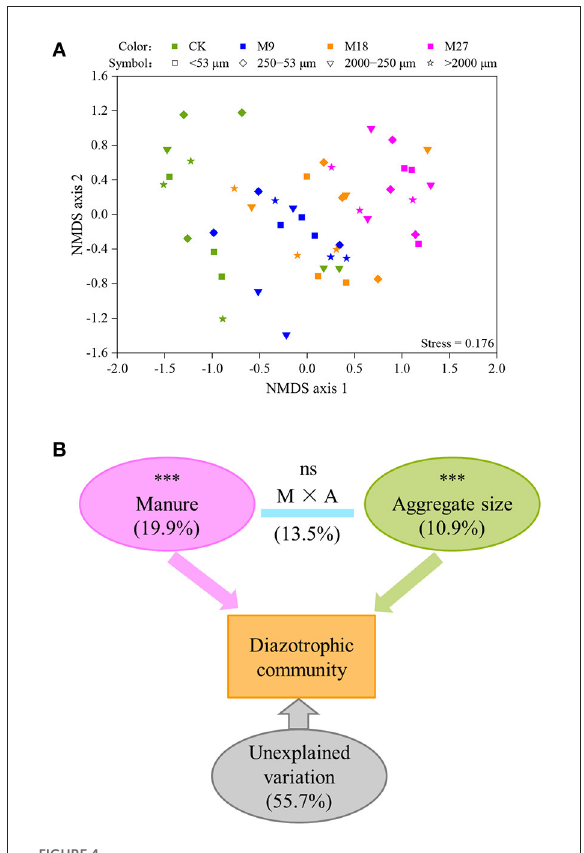
FIGURE4 NMDS (A) and PERMANOVA (B) analysis of the communities of diazotrophs. Different colors represent treatments and different symbols indicate aggregate sizes in panel (A) . In panel (B) , the numbers are the percent of variation explained, and the letters M and A denote manure and aggregate sizes, respectively. Asterisks (***) denote significant differences at p <